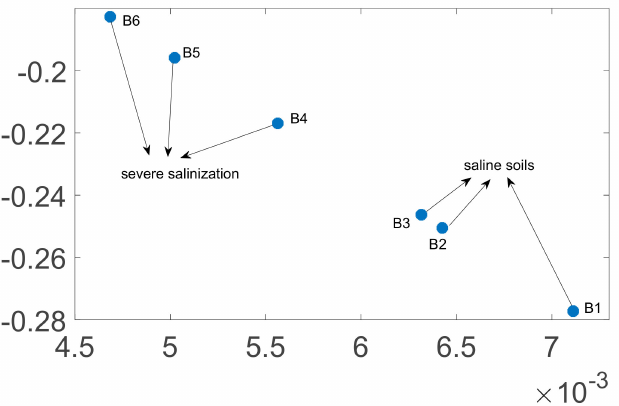
Figure 11. Chaotic attractor distribution for 0.6 order of the six sampling points in Area B.